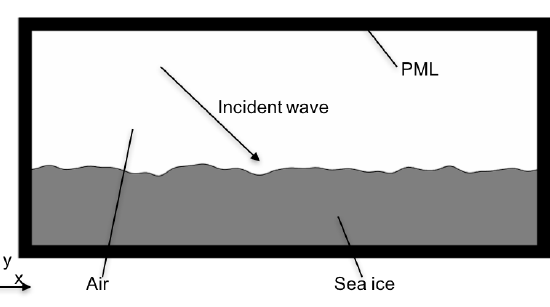
Figure 1. Geometry illustrating the computational domain for the sea ice